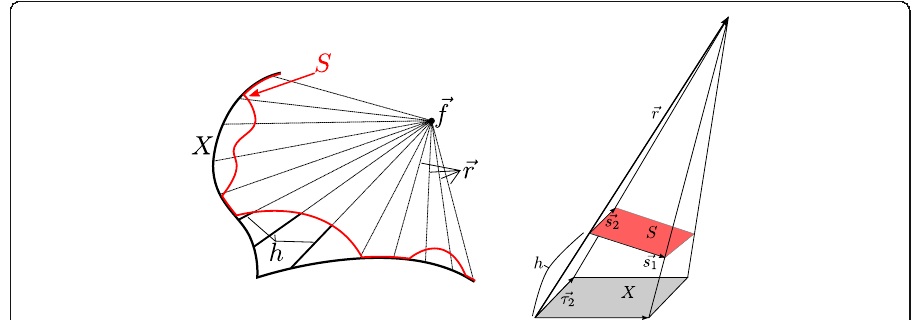
Fig. 3 Schematic of projection method, showing ( left ) selection of suitable focal point X and ( right ) labelled projection